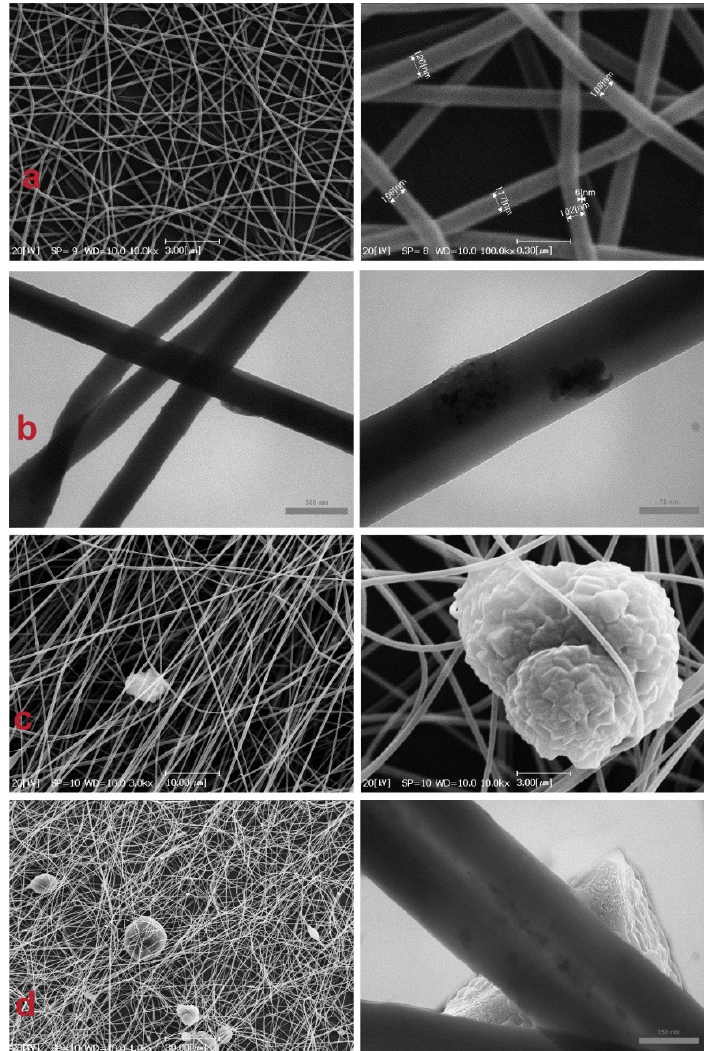
Figure 6. SEM and TEM images of electrospun nanofiber ( a ) PAN; ( b ) PAN/MWCNT; ( c ) PAN/MOF; ( d ) PAN/MWCNT/MOF.